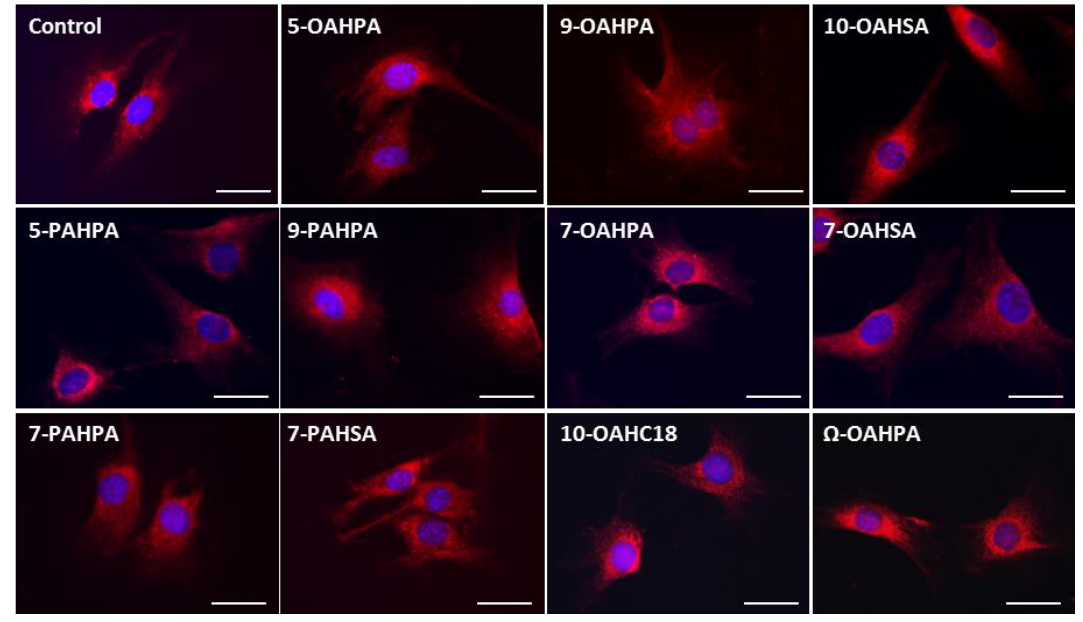
Figure 4. Influence of FAHFAs on mitochondrial network structure. The mitochondrial network structure was visualized using Mitotracker TM Red. Scale Bar, 20 µm.